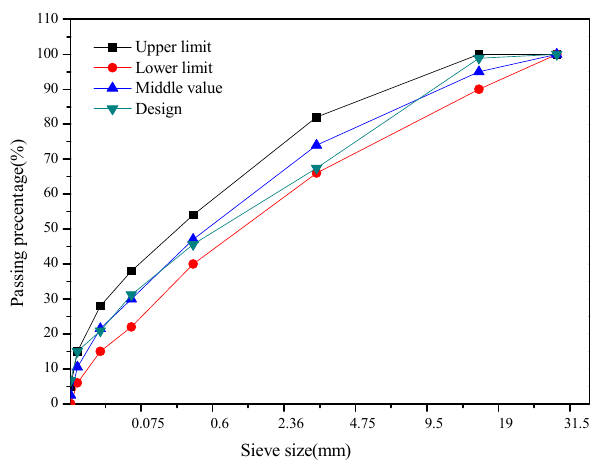
Figure 1. The gradation curve of the mixture.